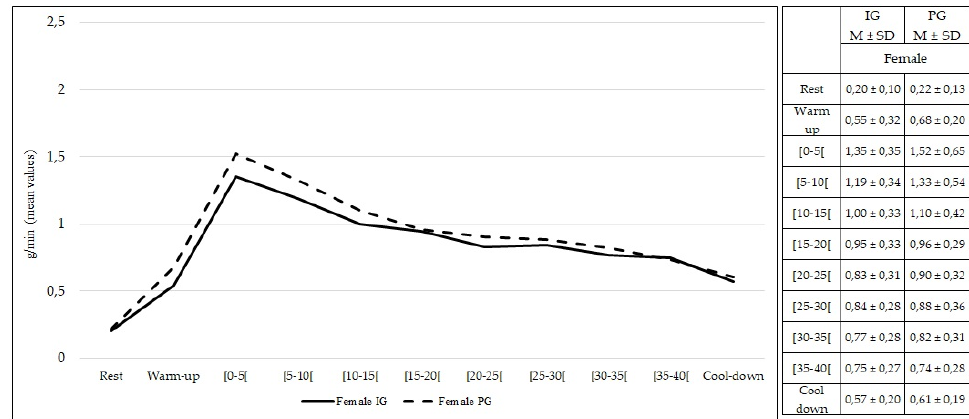
Figure 8. Carbohydrate oxidation during rest, exercise, and cool-down in females (intervention group vs. placebo group). Data are expressed as mean ± standard deviation. IG: intervention group; PG: placebo group.